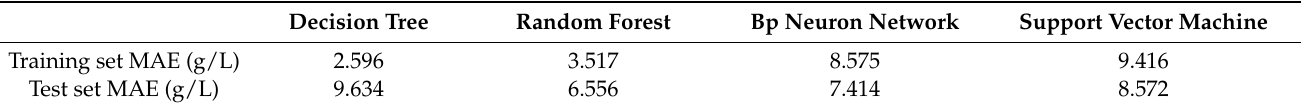
Table 5. The mean absolute error (MAE) of using secondary indexes value to predict PMLA produc- tion by four machine learning methods.